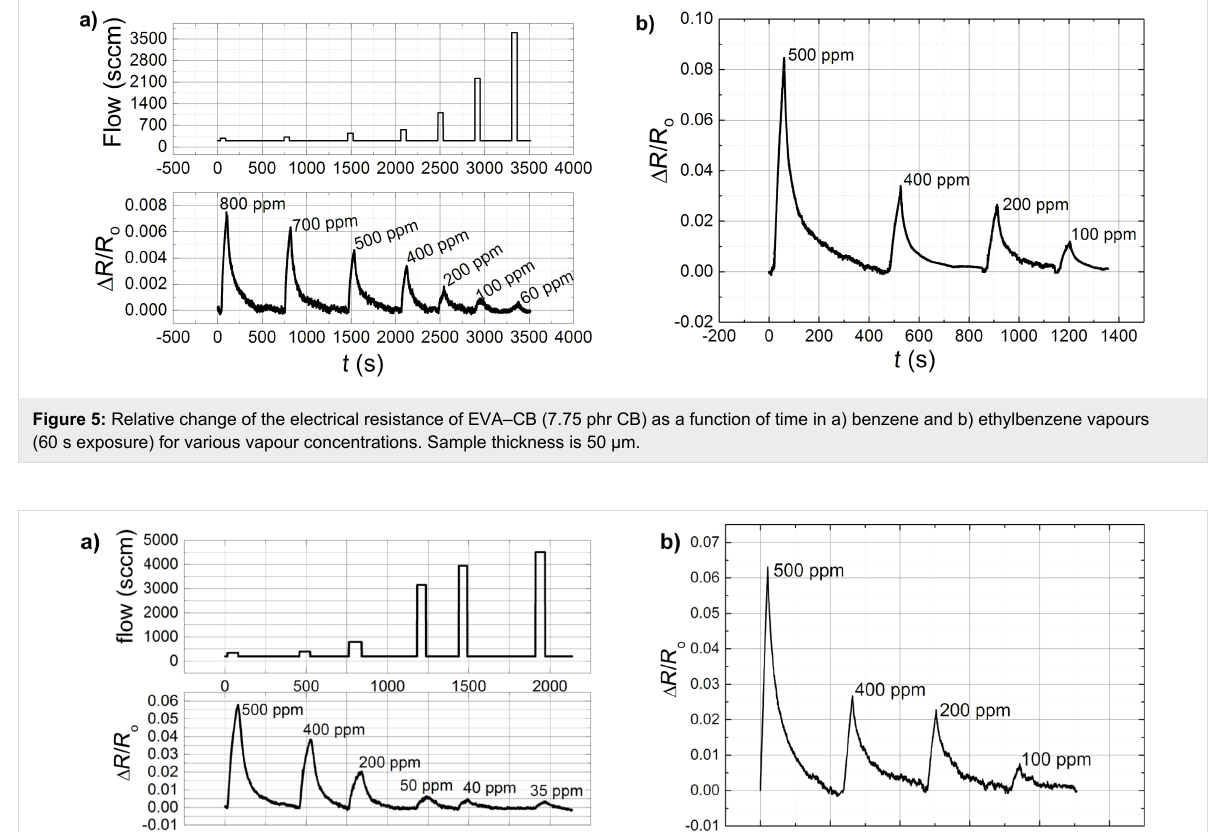
(the solvent with a bigger molecule) shows better